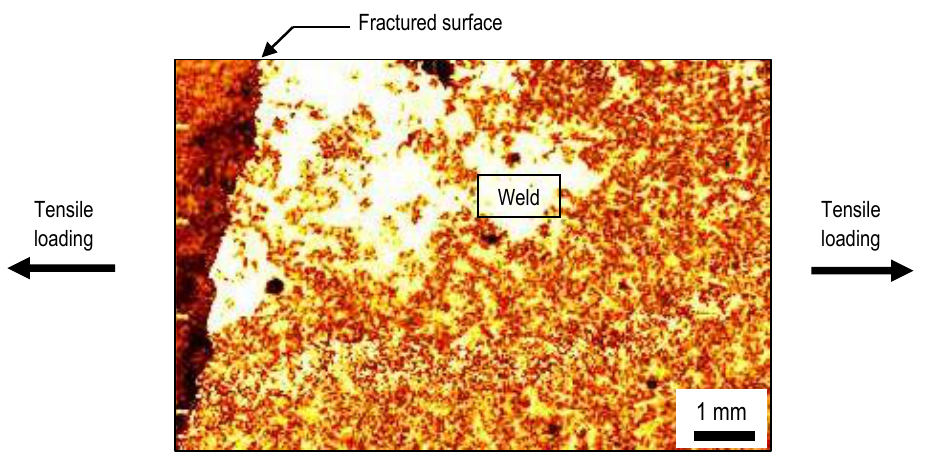
Figure 5: Fractured surface and microstructure of typical tensile specimen.